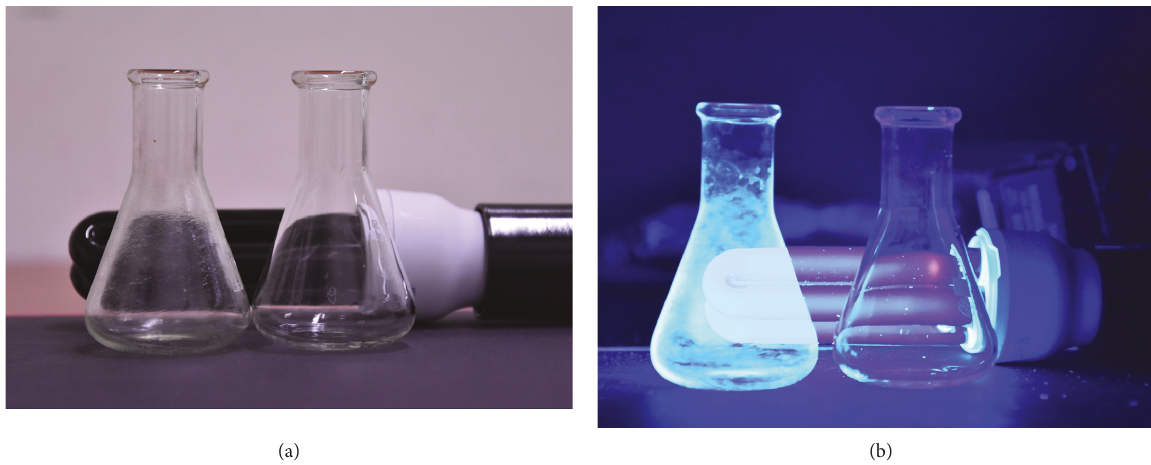
Figure 4: Two common laboratory flasks in natural light (above). The same flasks under a Wood’s lamp light (below). The flask on the left is pained with 10% NPh2-PS blend.